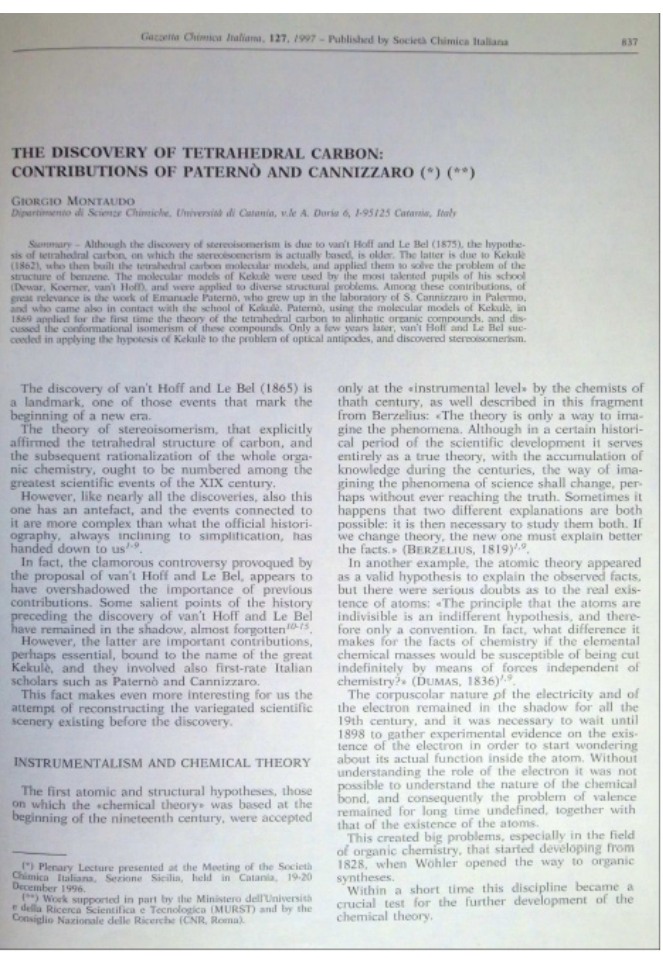
Figure 5. The first page of the last article published in the Gazzetta Chimica Italiana ( 1997 , 127 , 837–842) (from the Nerviano Medical Sciences